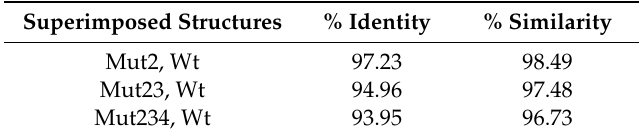
Table 2. Similarity of superimposed wildtype and mutant protein